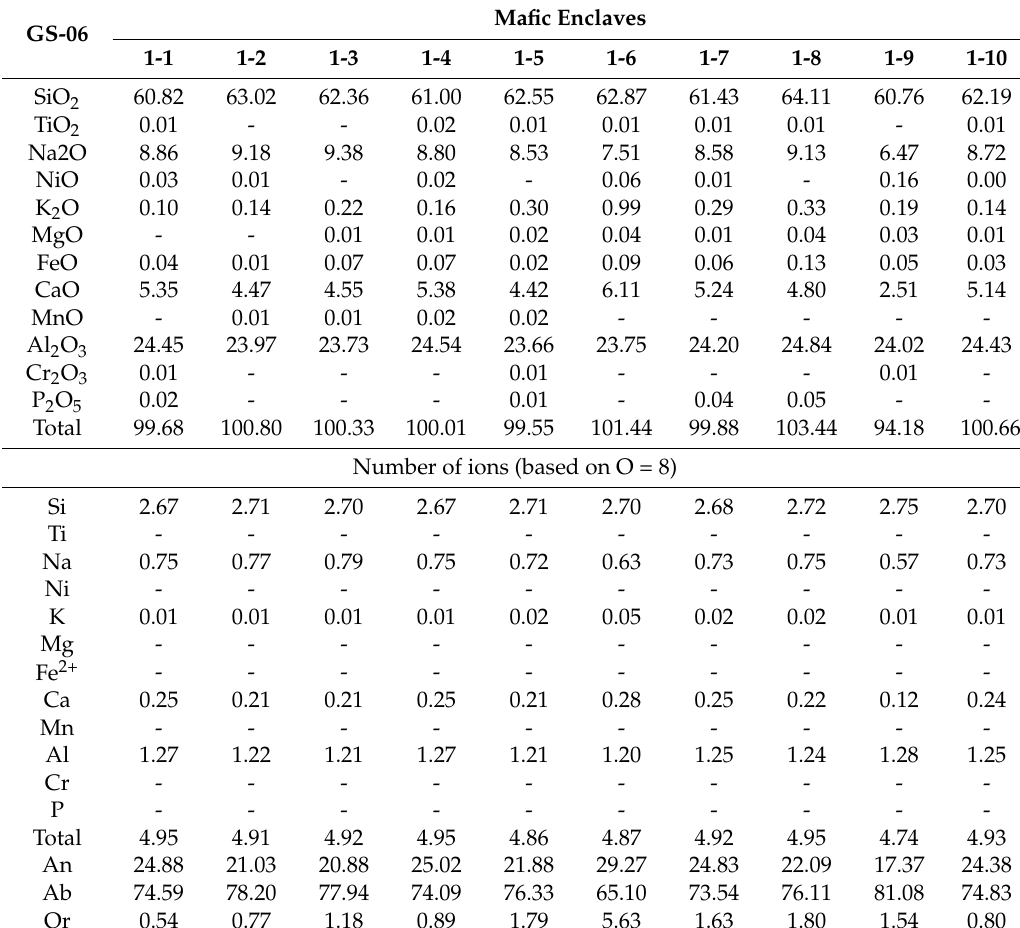
Table 2. Results of EPMA analyses of plagioclase crystals in the mafic enclaves of the Qingshanbao complex (wt